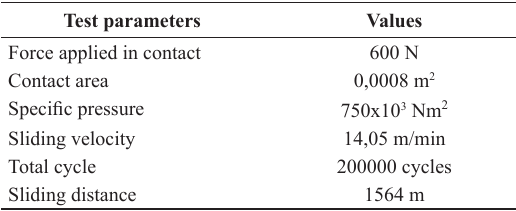
Table 2. Test parameters used for wear